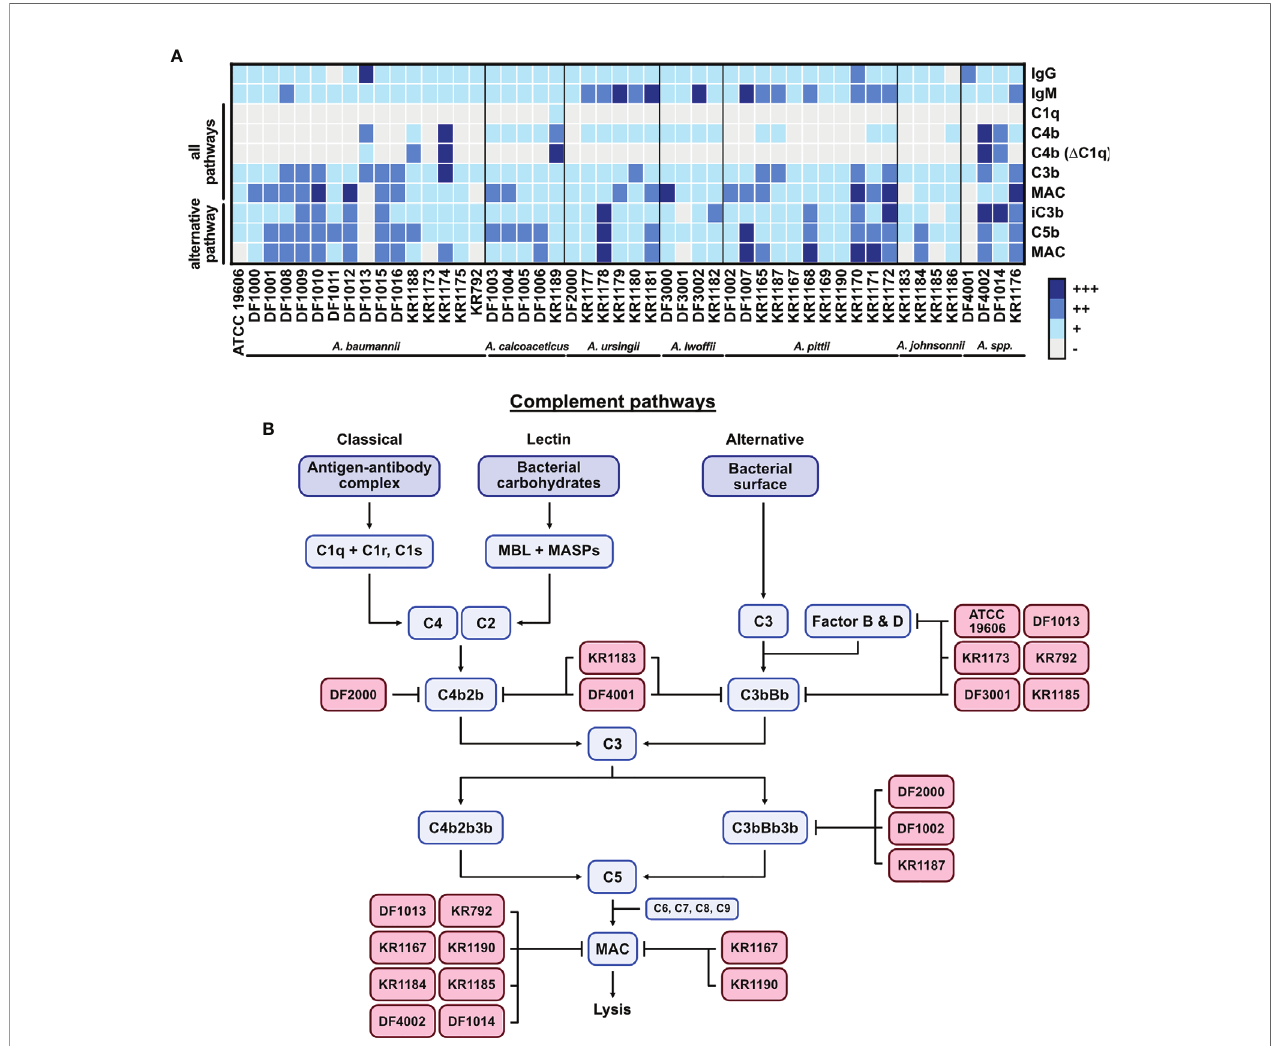
FIGURE 6 | Graphical summary of the study. (A) Summary of the complement activation data presented as a heat-map of deposition of each tested protein. Flow cytometry results for each isolate are arranged into 4 groups (+++ highest deposition, ++ moderate deposition, + low deposition, - no deposition/background level). Groups are created based on the percentage of the highest gMFI value for each deposited component. (B) The complement system activation cascade. Acinetobacter isolates with their potential targets in the cascade are